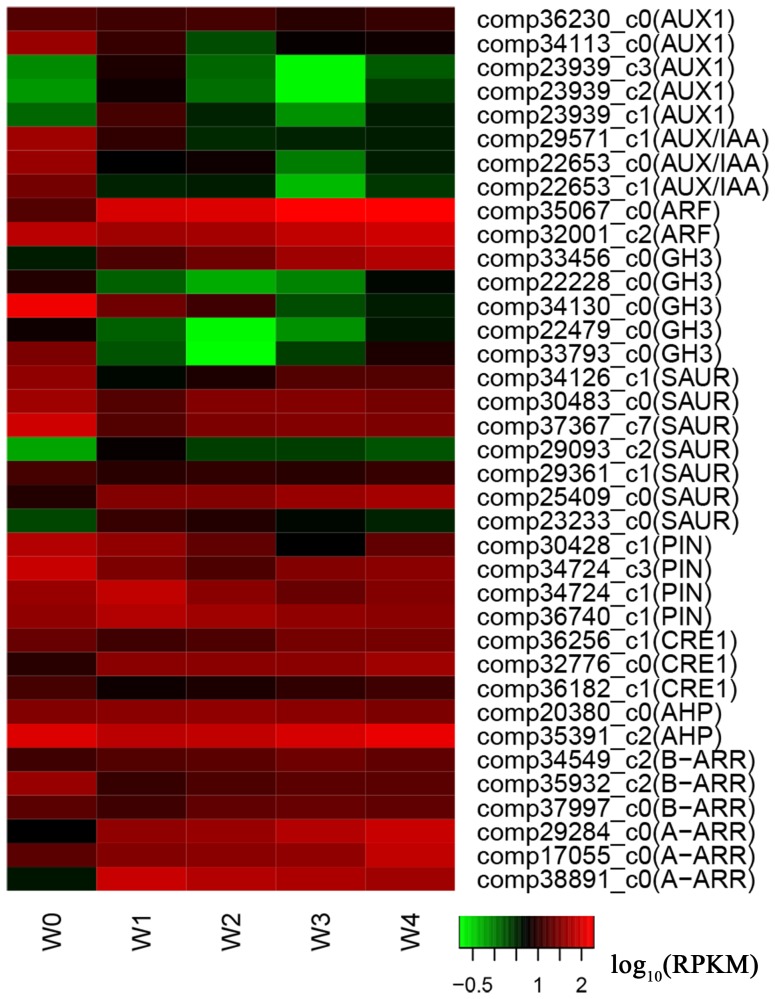
Differentially expressed genes related to auxin and cytokinin signaling.The relative expression levels were obtained by RNA-Seq after taking logarithmic transformations of RPKM.